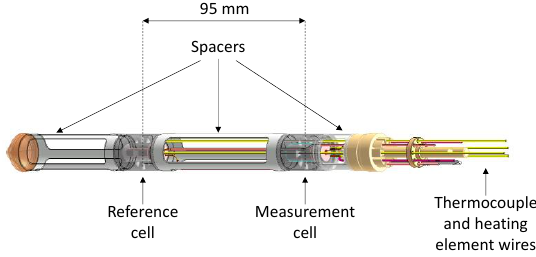
Fig. 2. 3-D scheme of the CALORRE differential calorimeter without its external additional